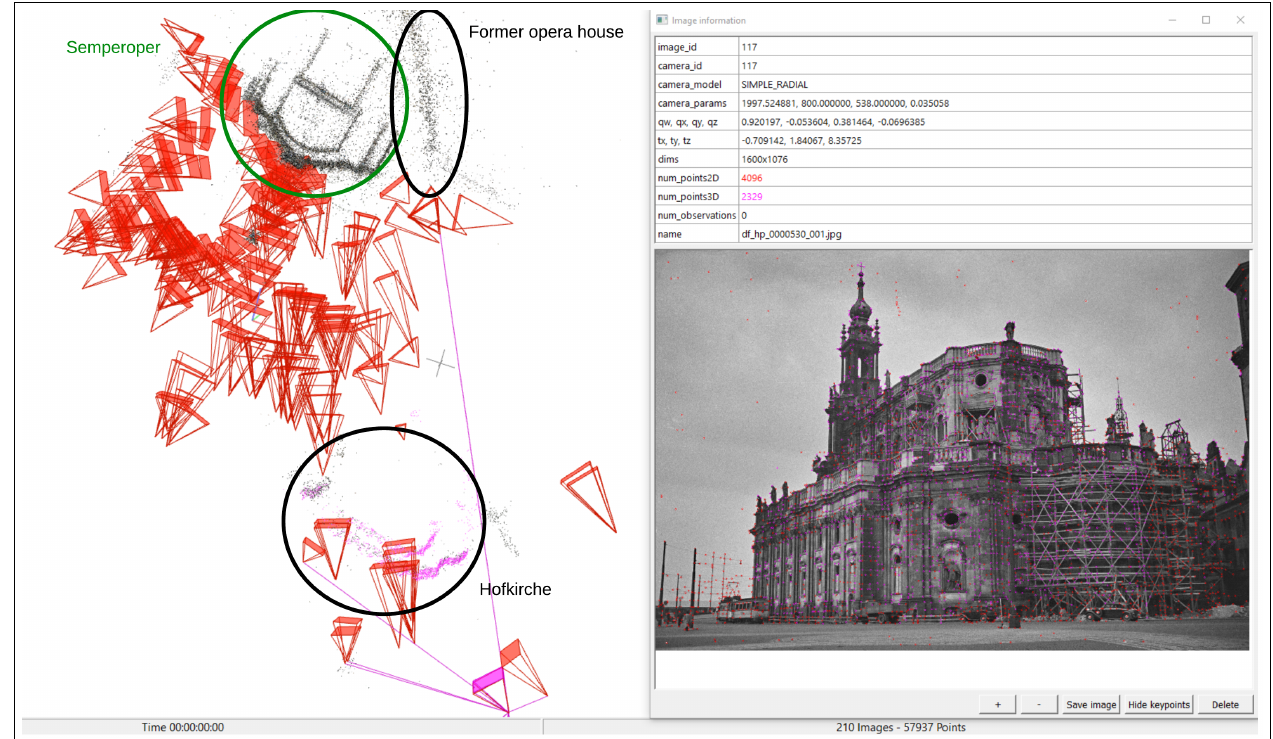
Figure 11. Initial COLMAP reconstruction of all Semperoper images retrieved by LEA. The green area marks the Semperoper at the correct position while images of Hofkirche (as seen from the Semperoper building) and the former opera house (black areas) introduce errors to the reconstruction. The orientation of the Hofkirche building is incorrect due to sparse image material accidentally retrieved by LEA and repetitive